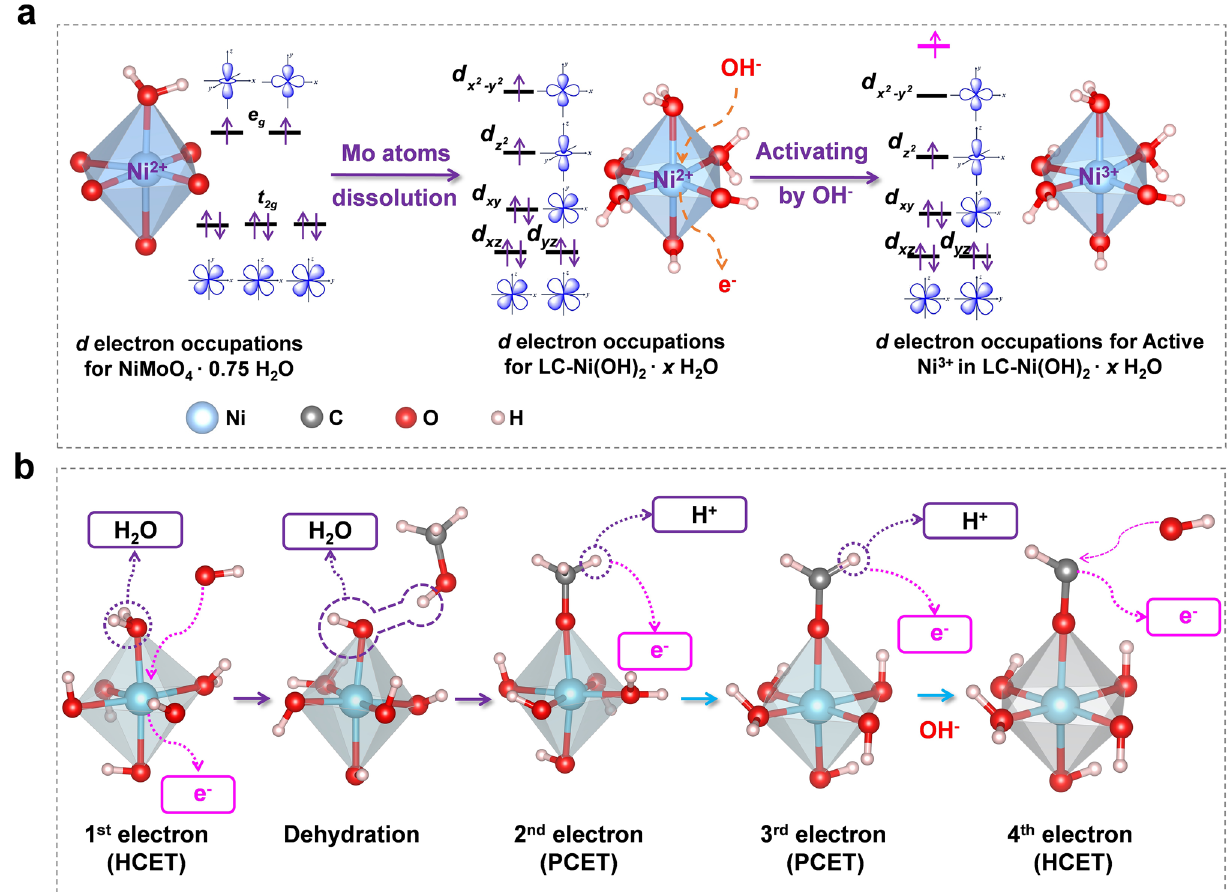
Fig. 6 a Illustration of d electron occupation for NiMoO 4 ·0.75H 2 O, LC–Ni(OH) 2 ·2.75H 2 O and activated LC–Ni(OH) 2 ·2.75H 2 O. b Illustration of methanol oxidation mechanisms with 4‑electron